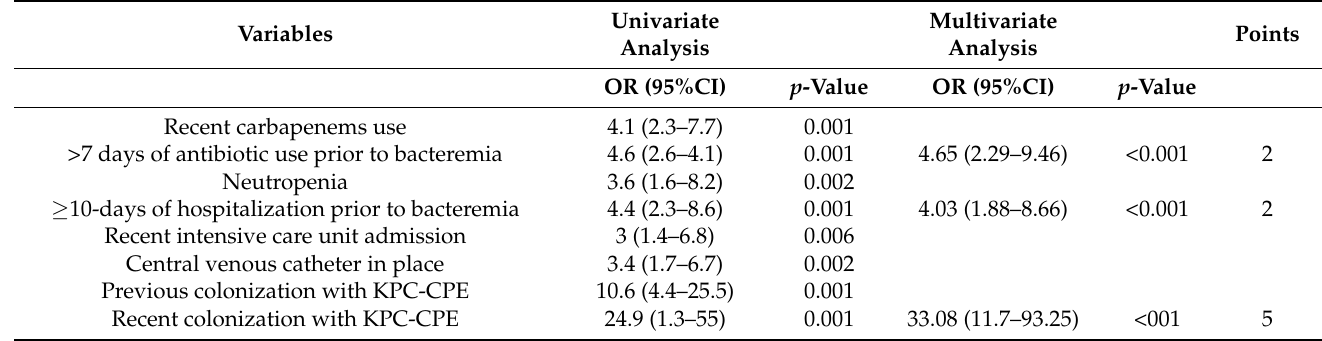
Table 3. Risk factors for carbapenem-resistant bacteremia and points assigned to the score.